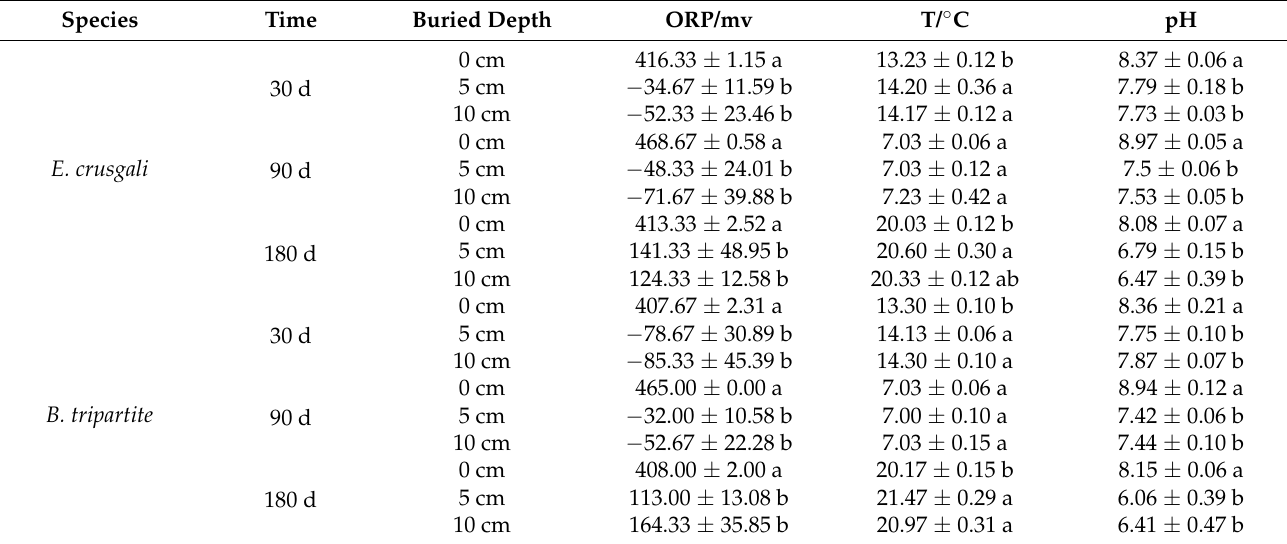
The soil pH value was up to 8.97 ± 0.05 at 90 d without burial and down to 6.06 ± 0.39 at 180 d under 5 cm burial. Table 2. Soil oxidation–reduction potential, temperature, and pH values of E. crusgali and B. tripartite litter after 30, 90, and 180 days at 0, 5, 10 cm burial depths under flooding.